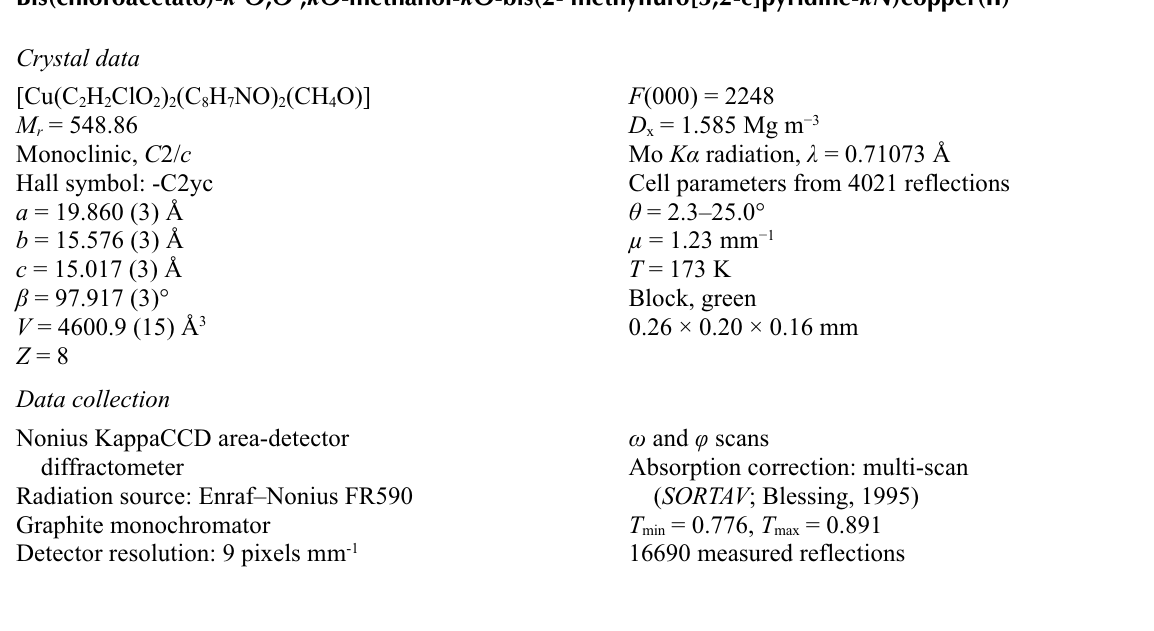
Figure 3 The C–H···O hydrogen bonds and CH/ π interactions in crystal structure of the title compound. Symmetry codes: (i) - x + 3/2, - y + 3/2, - z + 1; (v) - x + 3/2, y + 1/2, - z + 1/2]. Bis(chloroacetato)- κ 2 O , O ′ ; κ O -methanol- κ O-bis(2- methylfuro[3,2- c ]pyridine- κ N